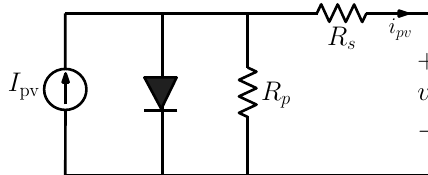
Figure 3. The single-diode five-parameter equivalent circuit diagram of the PV generator according to (1) [31].